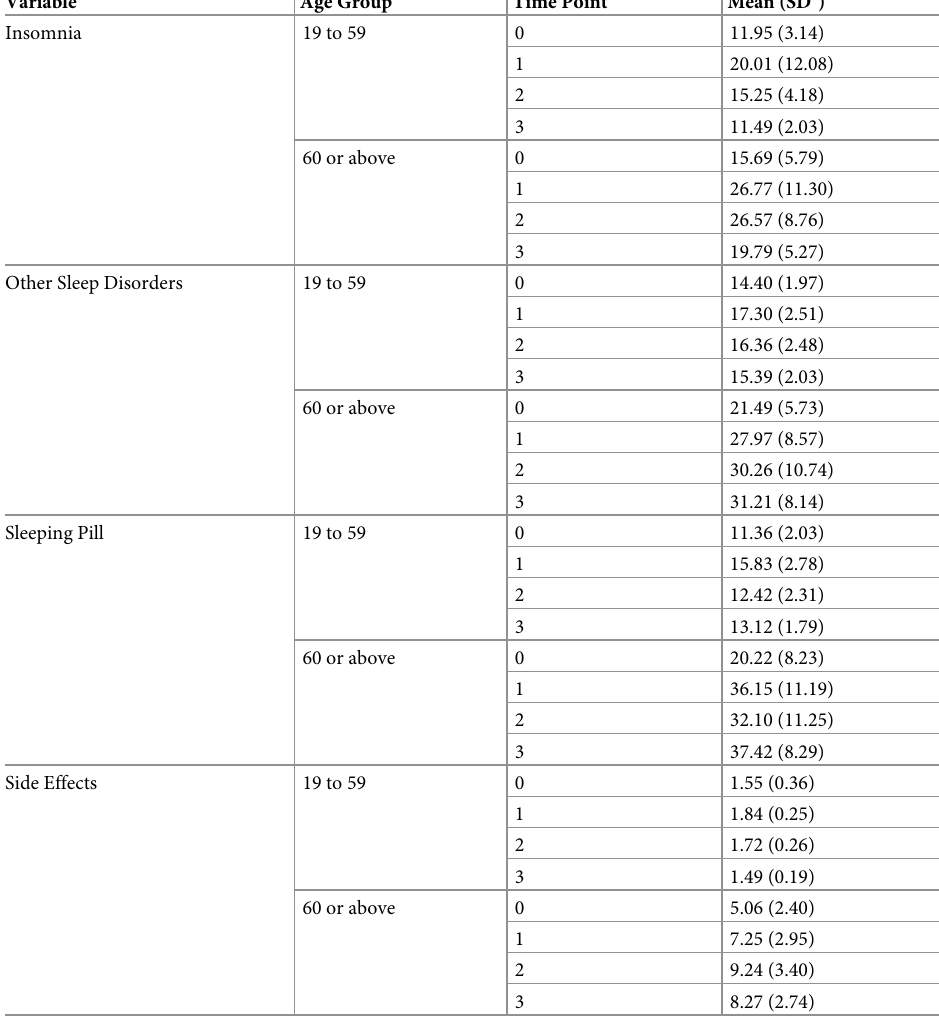
Table 1. Means and standard deviations of RSV data for each search term category, arranged according to age group and time point.